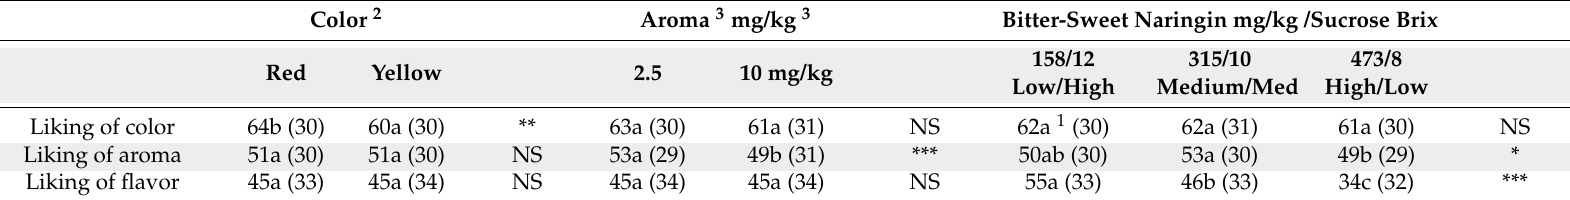
Table 4. The effect of varying the color, aroma, and bitter/sweet gustatory flavorants on mean liking ratings 1 ( ± standard deviation) for color, aroma, and flavor of grapefruit-like beverages by ( n = 90)